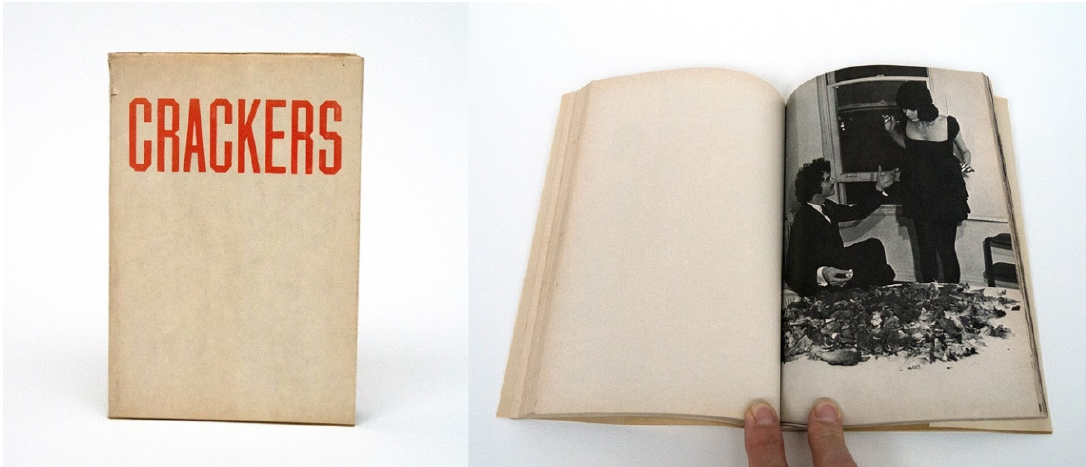
Figure 6. Edward Ruscha, Crackers , 1968.